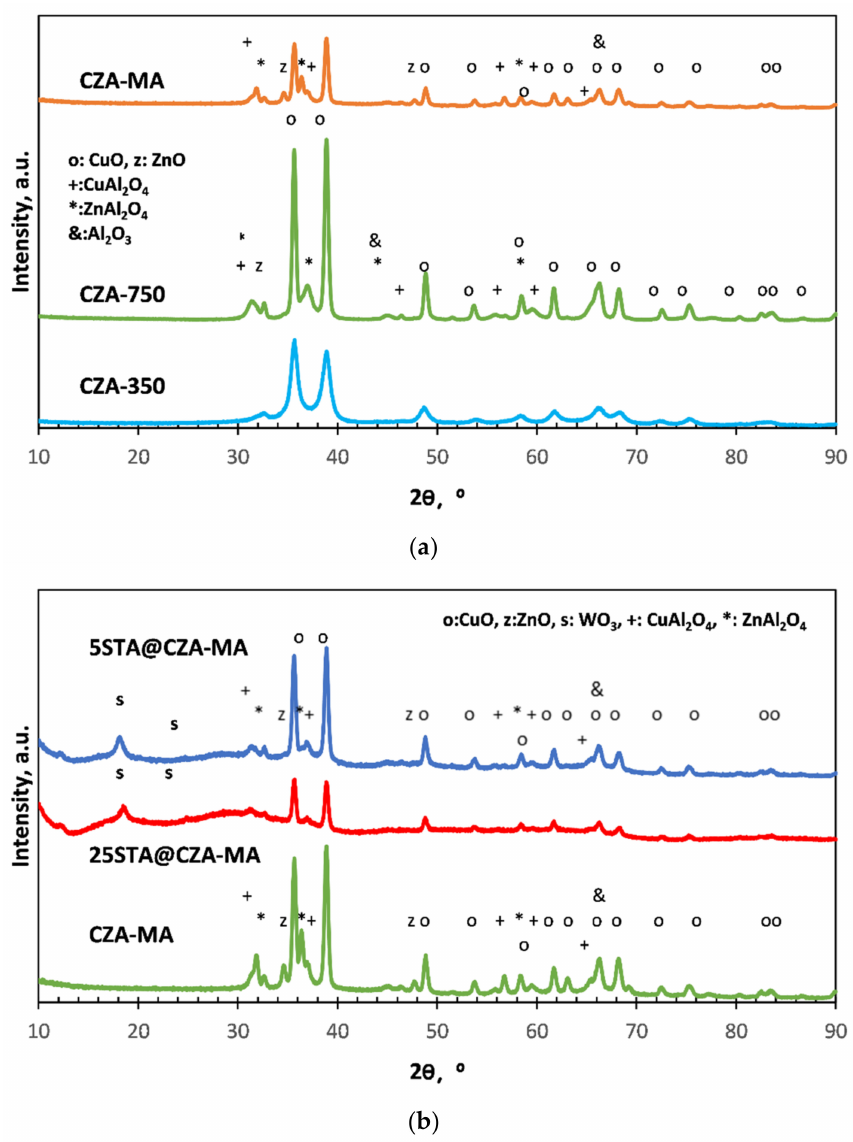
Figure 1. ( a ) XRD patterns of methanol synthesis catalysts and core-shell model catalyst, ( b ) XRD patterns of STA incorporated core-shell model